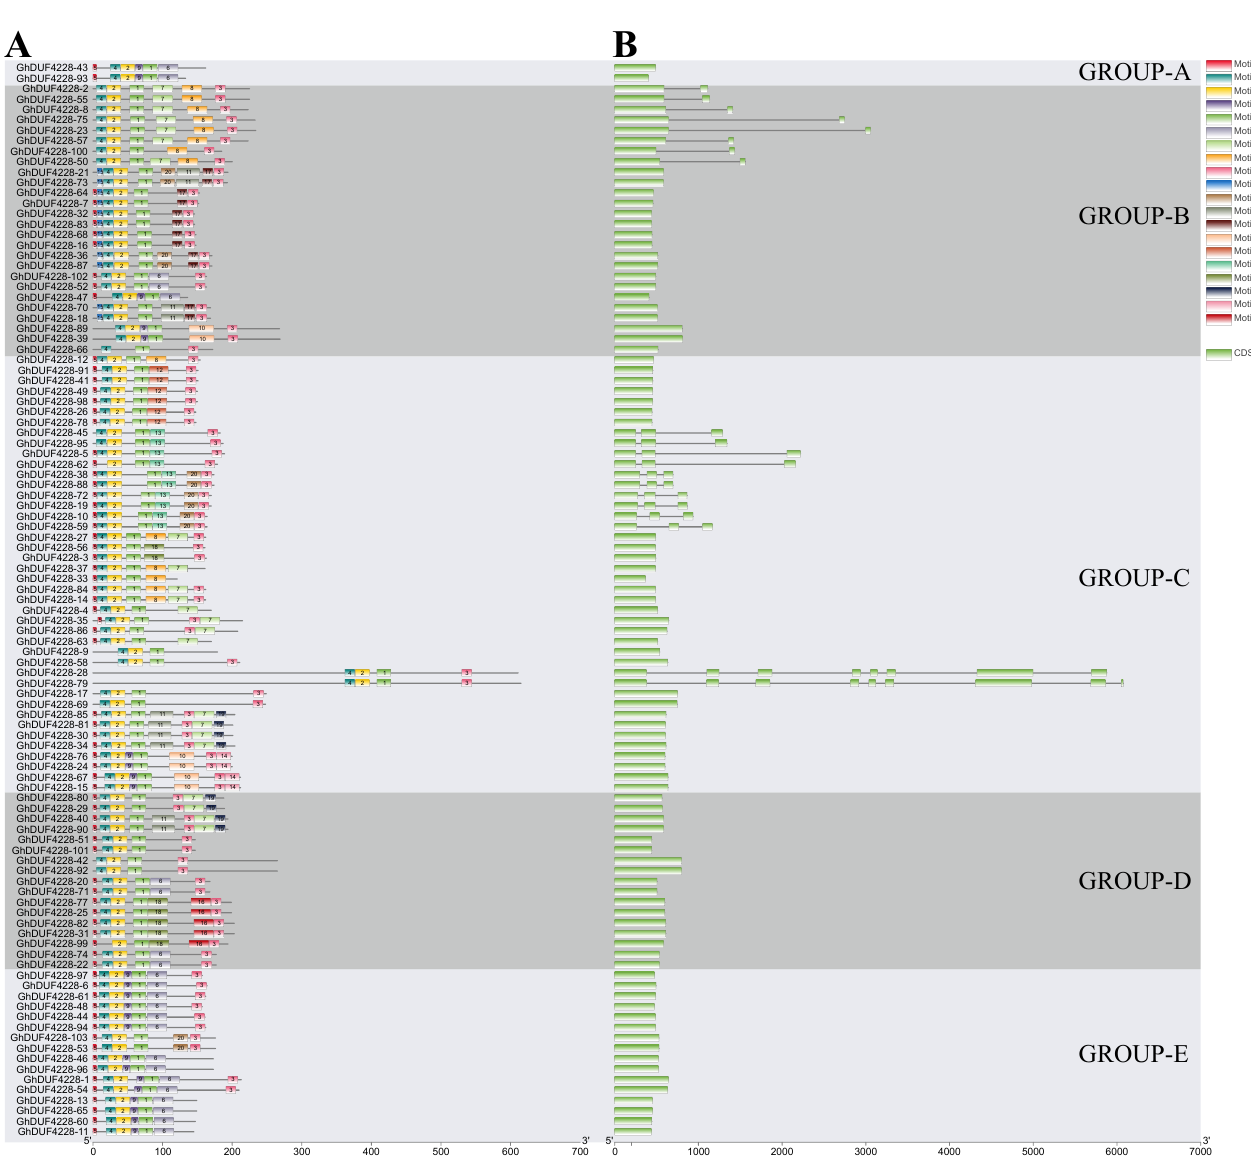
Figure 2. Conserved protein motifs and gene structure analysis of GhDUF4228 genes. ( A ): Conserved motif distribution in the GhDUF4228 genes, with 20 motifs represented by boxes with different colors. ( B ): The exons and introns of the GhDUF4228 genes are represented by green boxes and black lines, respectively. The scale at the bottom is used to infer the length of proteins and